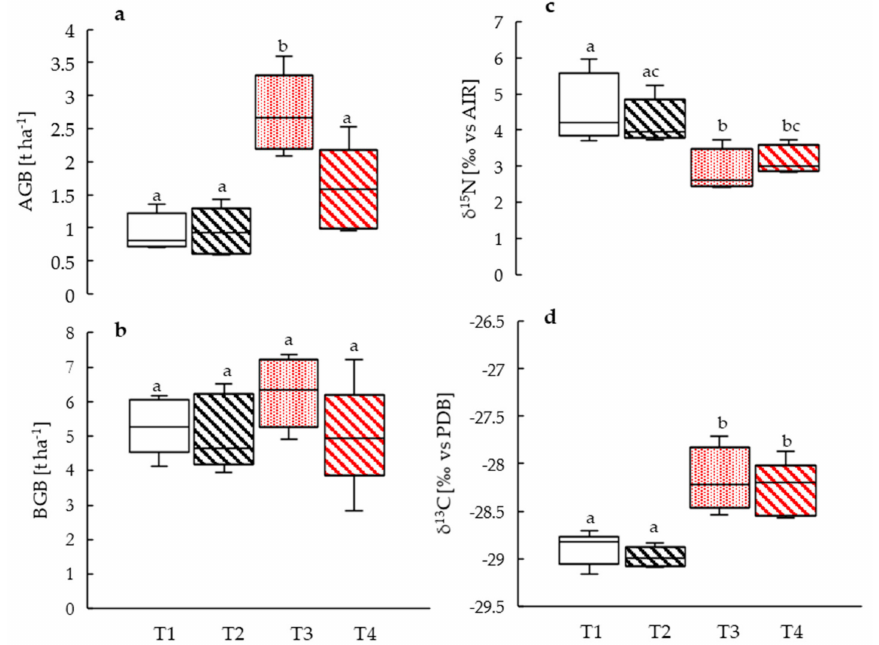
Figure 6. Characteristics of harvested biomass and isotopic composition of C and N in the aboveground biomass (AGB). ( a ) AGB, ( b ) belowground dry biomass (BGB), ( c ) δ 15 N values in AGB, and ( d ) δ 13 C values in AGB. The vertical line within each boxplot represents the median value. Di ff erent letters refer to significance variations ( p < 0.05). T1 refers to the control